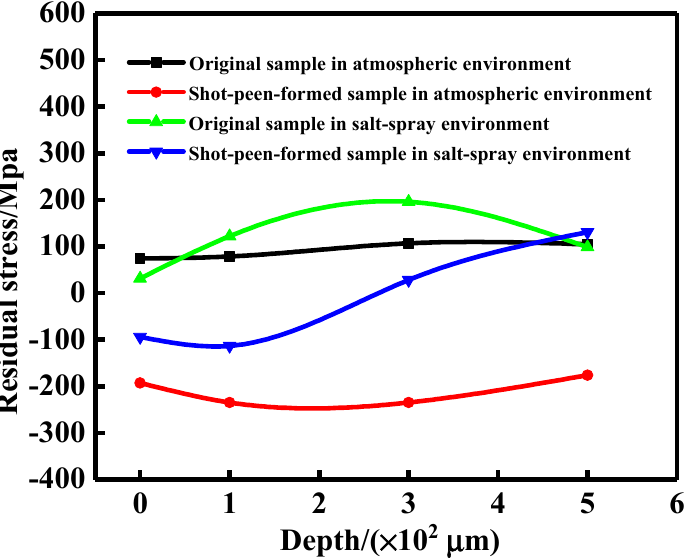
Figure 8. Residual stress distribution of the original and shot-peen-formed samples.